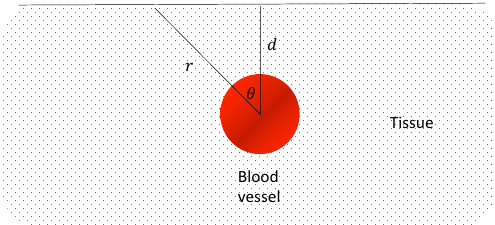
Figure 7. Geometry used for theoretical calculation. The circle represents the cross section of blood vessel with parameters: D in , W 1 , k 1 , µ in a , µ (cid:48) in s ; The area outside the circle represents the static scattering media, i.e., tissue with parameters D out , W 0 , k 0 , µ out a , µ (cid:48) out s . We adopt cylindrical coordinates and define the center of the vessel as the origin.